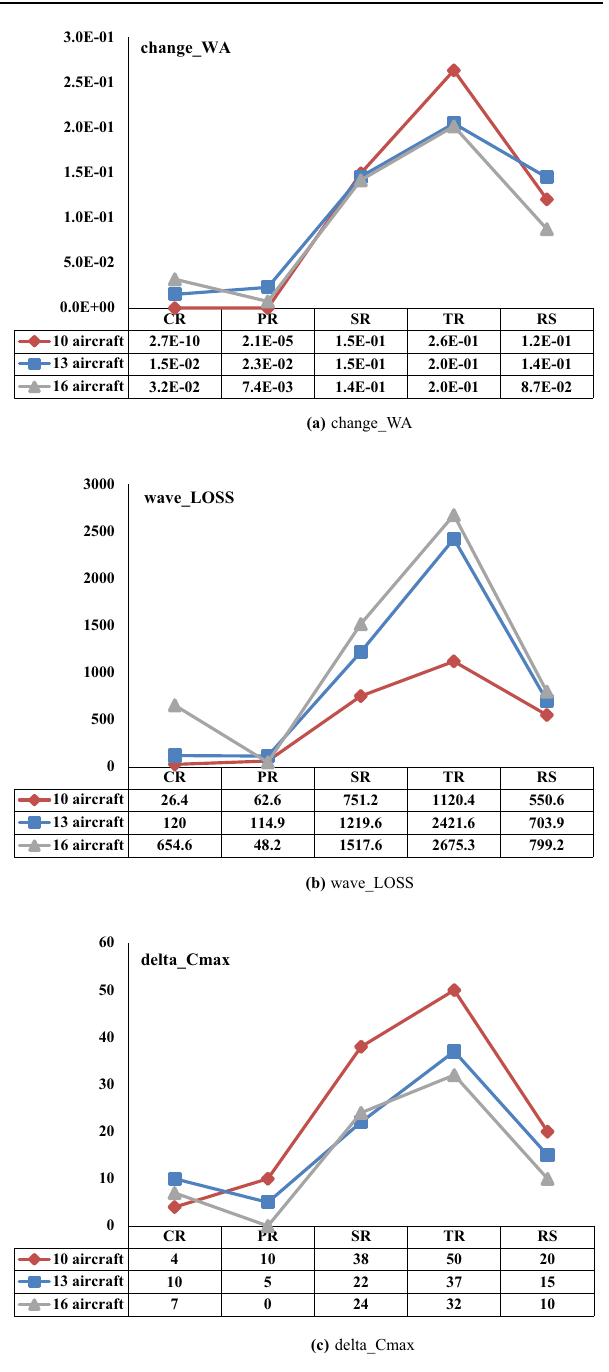
Fig. 14 Data comparison of different reactivity methods